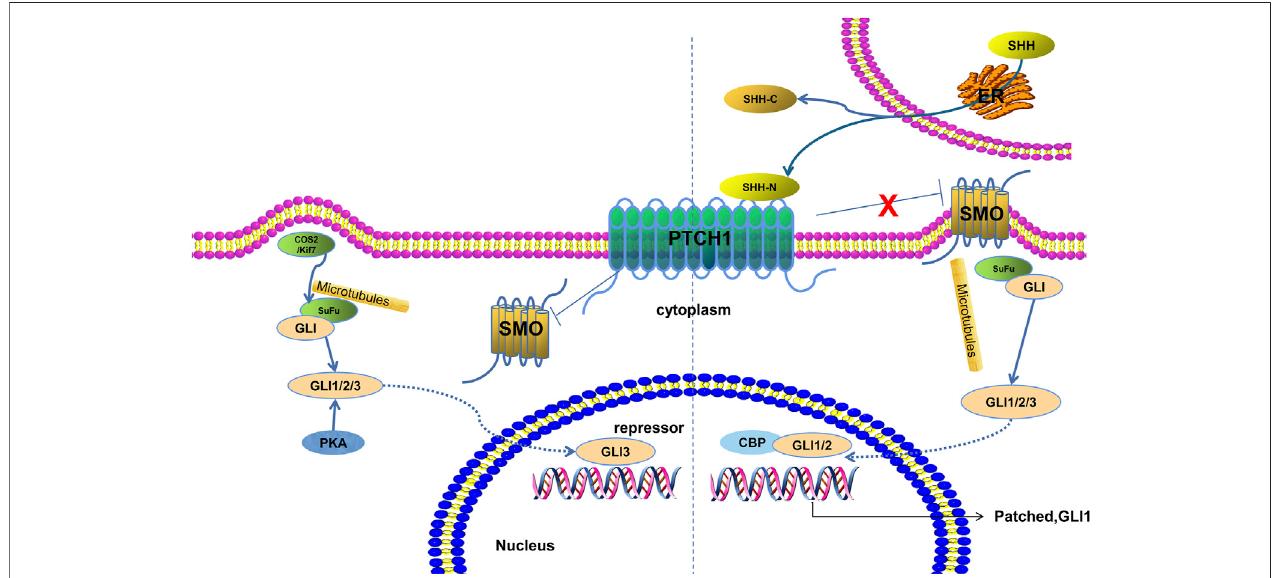
FIGURE 1 | Sonic hedgehog signaling pathway. Two states are depicted. Under normal conditions, PTCH1 inhibits the activity of SMO protein, thereby inhibiting the downstream pathway. COS2/Kif7 and PKA play a negative regulatory role. When PTCH1 binds with SHH, the inhibition of SMO is released and the GLI protein and microtubule complex enters the nucleus to activate downstream target gene